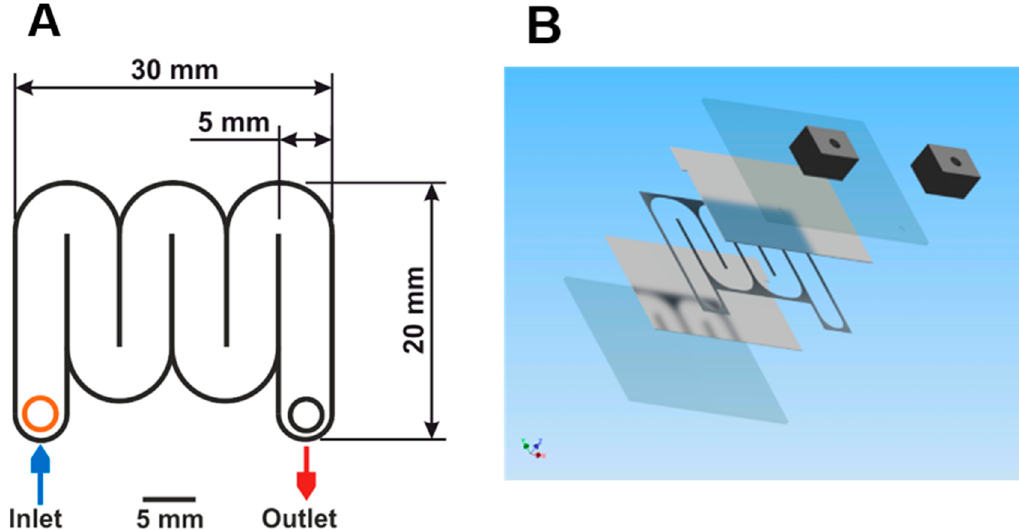
Figure 4. ( A ) Top view onto the microfluidic chip. The meander-type channel has a width of 5 mm, a length of 120 mm, and a height of 10 or 20 µ m. Top and bottom of the channel consist of glass slides covered with platinum. Overall chip dimensions: 30 × 20 × 1 mm. ( B ) Exploded 3D view of the chip. From bottom to top: glass substrate, platinum layer, SU-8 with a serpentine channel, platinum layer, glass substrate, PDMS connectors for inlet and outlet.